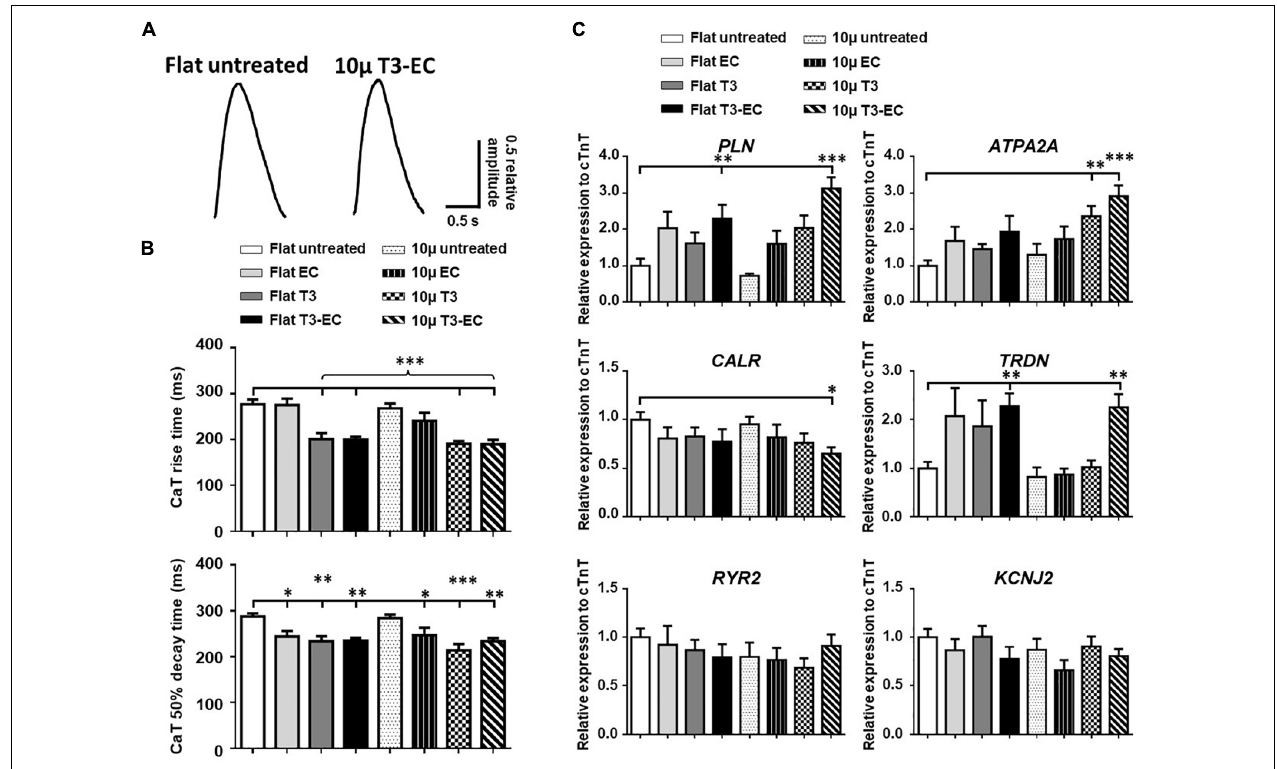
FIGURE 4 | T3-EC improves calcium handling properties in hvCAS. (A) Representative tracings by calcium transient (CaT) optical mapping hvCAS with different treatments. (B) CaT rise time and 50% decay time (CaT 50 ) measured by calcium transient optical imaging (three batches of independent differentiations; n = 5–6 for each group). (C) Changes in mRNA expression levels of calcium handling genes (11 batches of independent differentiations). (B,C) One-way ANOVA test followed by Dunnett multiple comparison test to flat untreated group. ∗ p < 0.05, ∗∗ p < 0.01, and ∗∗∗ p <